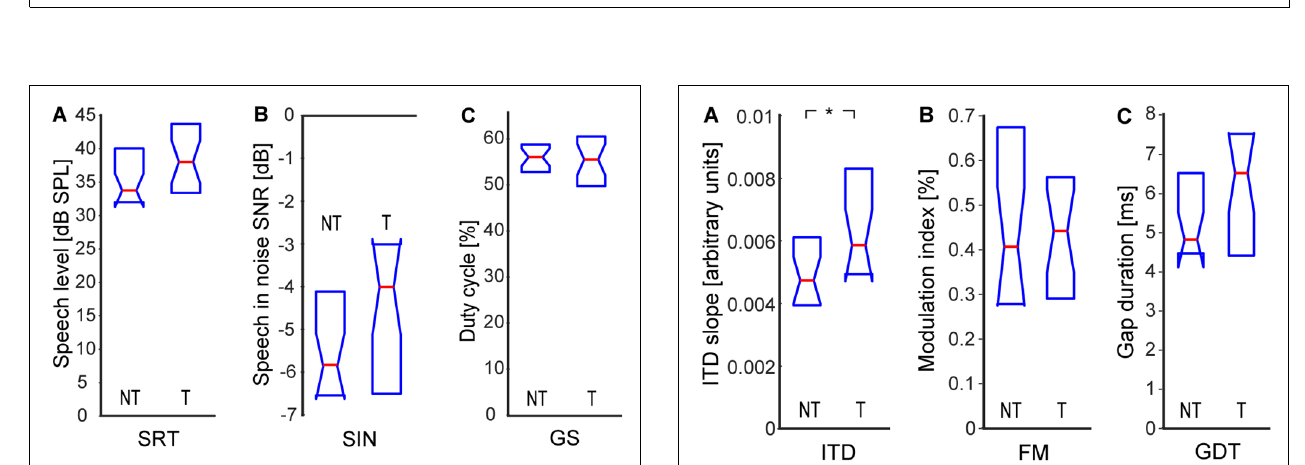
were significantly different (linear regression with an F -test, p <